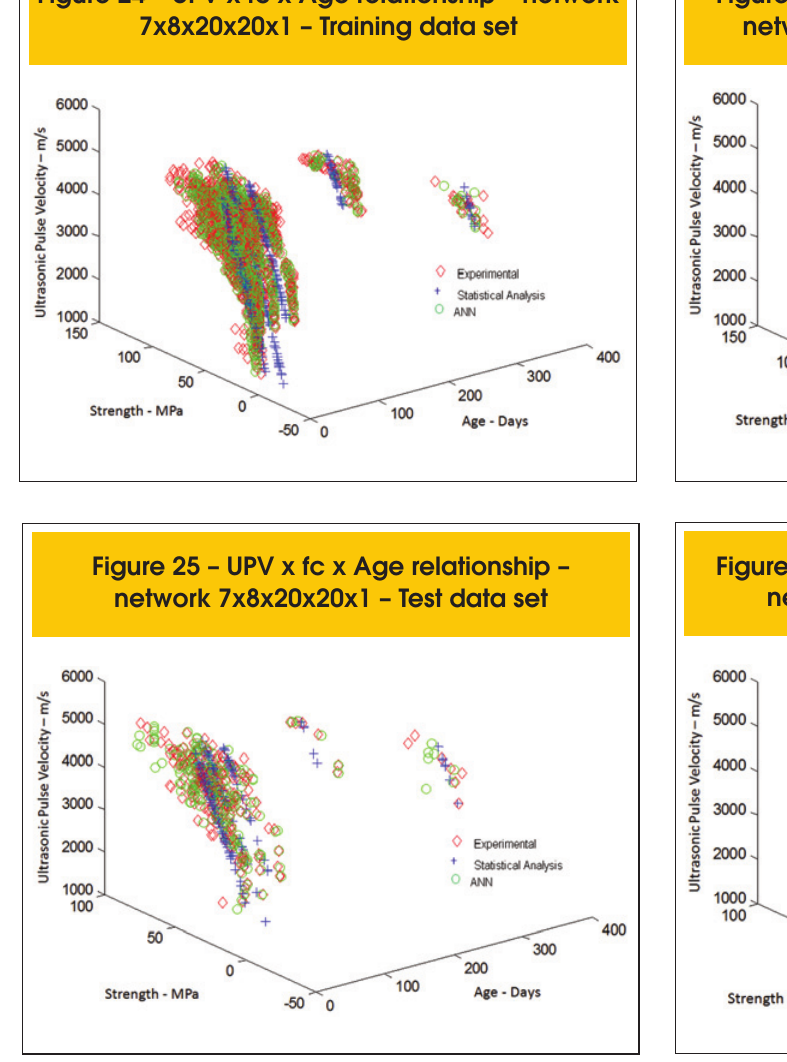
Figure 24 – UPV x fc x Age relationship – network 7x8x20x20x1 – Training data set